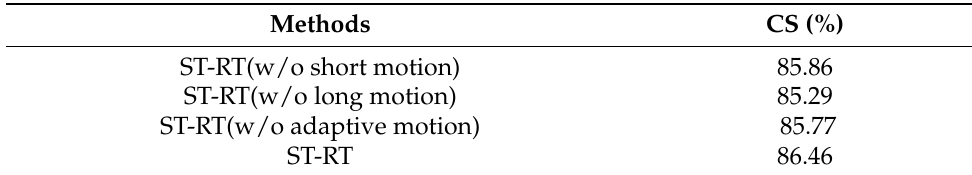
Table 5. Accuracy comparison of the ST-RT models with different motion and their combination. “w/o” equals without.